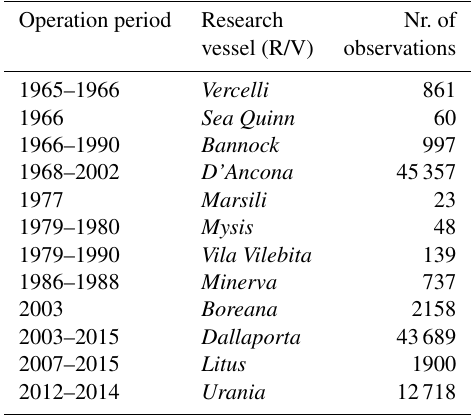
Table 1. Operation periods of the different research vessels between 1965 and 2015 and number of